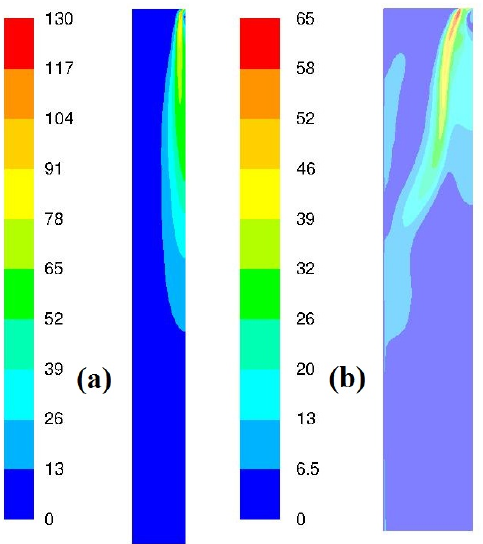
Figure 26. Gas velocity magnitude in m/s where the right vertical line represents the axis of symmetry: ( a ) Reactor 1 and ( b ) Reactor 2.